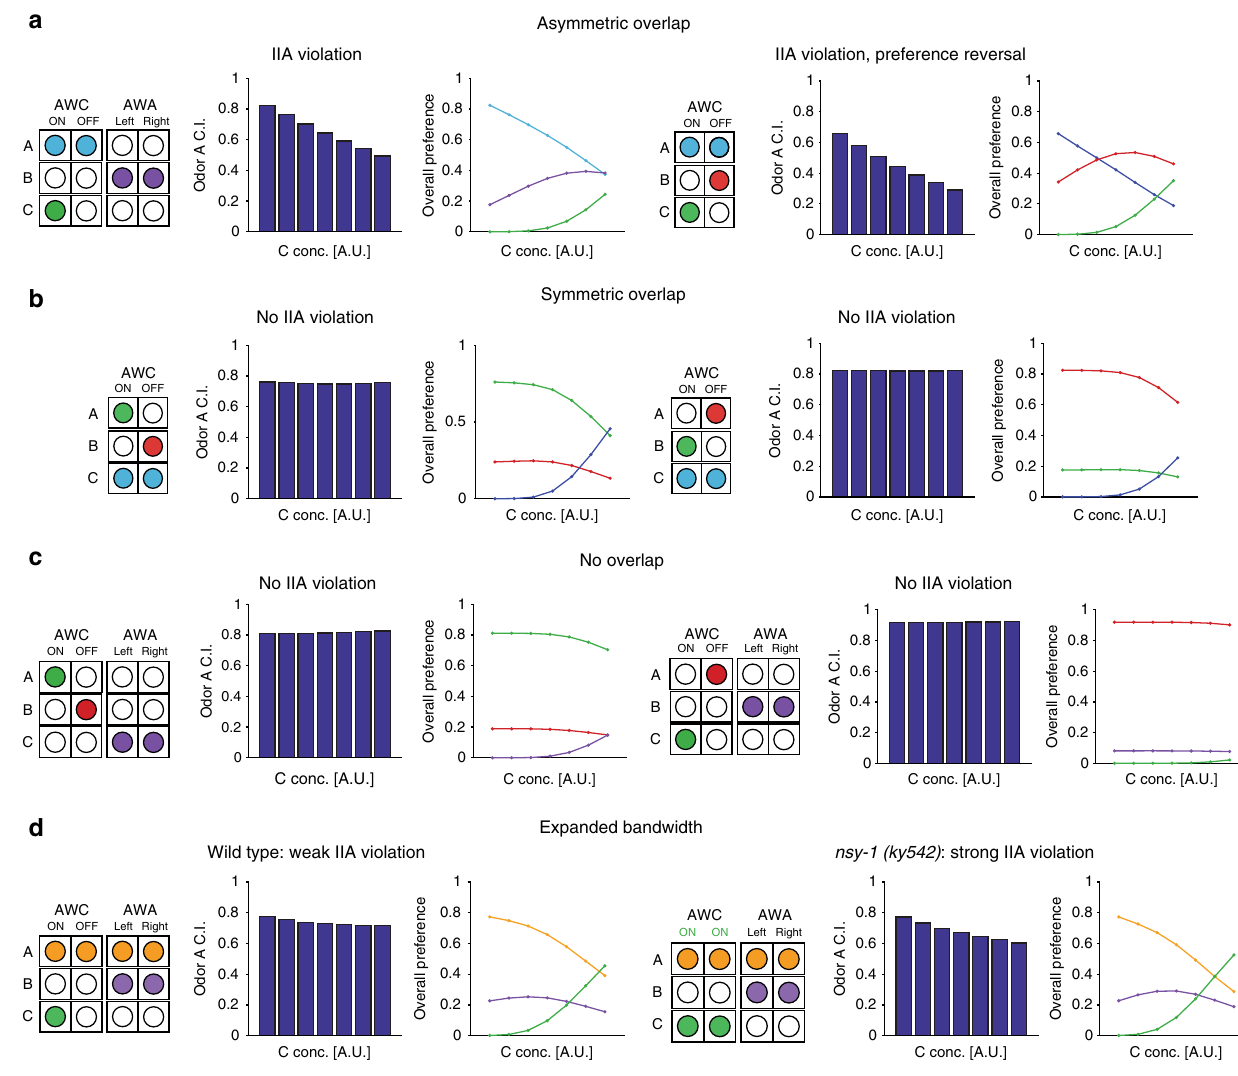
Fig. 4 Sensory gain control model of chemosensation explains circuit architecture-speci fi c IIA violations. Predicted choice behavior in a divisive normalization model of sensory gain control in C. elegans chemosensation. Odors driving the same chemosensory neuron are assumed to drive cross-odor normalization in neural representation. Simulation parameters were not fi t to empirical choice data, but instead were chosen to demonstrate qualitative similarity in behavioral data under different circuit activation patterns. Each combination was simulated for n = 10 6 repetitions. In each combination, the left panel shows the circuit activation pattern, the middle shows the preference index for odor A (relative choice of odors A vs. B), and the right shows the model-predicted preference for the odors. Our results indicate that IIA violations can occur due to an asymmetric overlap between odors “ A ” and “ C ” . a Model-predicted IIA violations in asymmetric overlap circuit architectures. When odors A and C both activate AWC ON , increasing concentrations of odor C reduce the representation of odor A in the model via cross-odor normalization. The model captures IIA violations with (right) and without (left) preference reversals, both of which are observed in the empirical data. b Model-predicted rational choice behavior in symmetric overlap circuit architectures. In symmetric circuits where odor C activates neurons sensing both odor A and odor B, cross-odor normalization affects the neural representations of both high-value odors. Increasing concentrations of odor C affects the neural representation of odors A and B similarly, and relative preference does not vary. c Model-predicted rational choice behavior in nonoverlap circuit architectures. In these circuits, odors A and C activate distinct chemosensory neurons and no cross-odor normalization occurs in the model. Thus, the neural representations of odors A and B (and the relative choice preference of A over B) do not vary with the concentration of odor C. d Model behavior in expanded-bandwidth circuits. In expanded-bandwidth scenarios, odor A activates both AWC and both AWA neurons. In wild-type worms, cross-odor normalization only affects 25% of the neural representation of odor A and the model predicts weak IIA violations (left). In nsy-1 mutants with two AWC ON neurons, cross-odor normalization affects 50% of the representation of odor A and the model predicts stronger IIA violations alcohol (Supplementary Fig. 11a, b) as well as the difference in binary preference between these two odors in wild-type vs. AWC ON/ON mutants (Supplementary Fig. 11c).